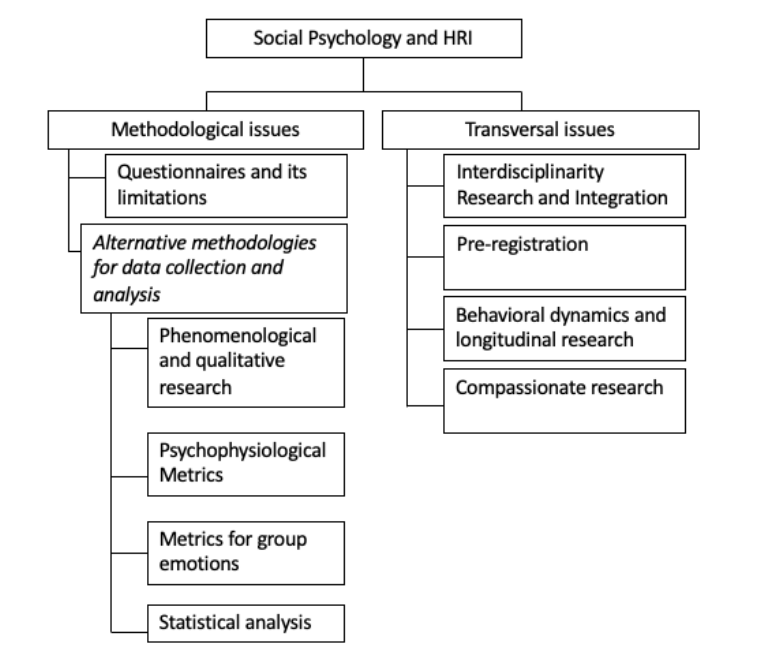
Figure 2. Schematic representation of the framework of this